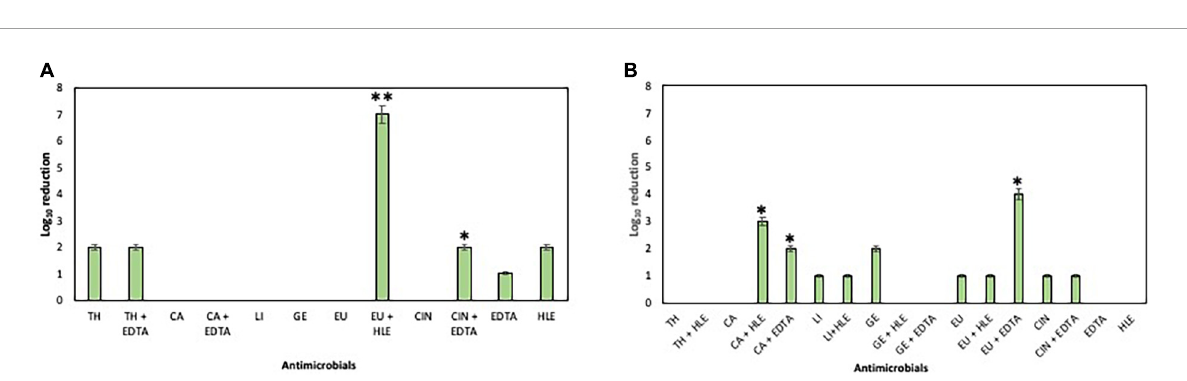
FIGURE5 Log 10 reduction of established biofilms of Enterococcus sp. strains M28M11 (A) and M28M12 (B) after 30 min treatment with EOCs (TH, CA, LI, GE, EU and CIN), EDTA, HLE or their synergistic combinations. (*) and (**) indicate a statistically significant synergistic effect and total elimination of established biofilm,